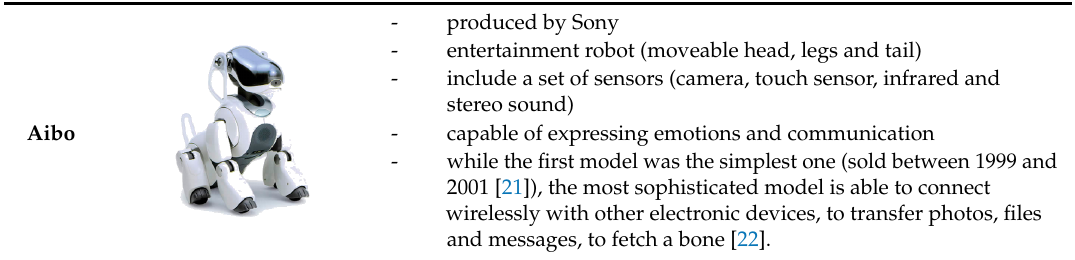
Table 2. A selection of assistive social robots (adapted after [20] (pp. 96–97) and completed with other references).